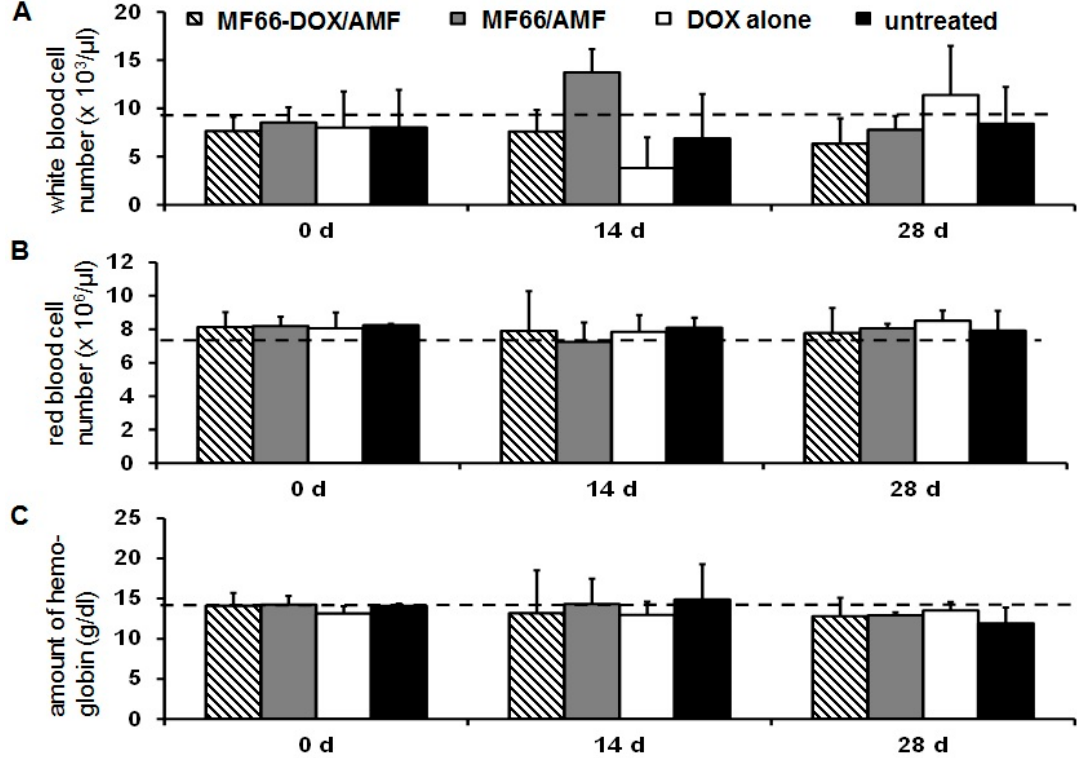
Figure 3. MNPs functionalized with DOX exert a good blood biocompatibility. White blood cells ( A ), red blood cells ( B ) and hemoglobin concentration ( C ). Mean ± standard deviation (n ≥ 4 mice per group). Dashed lines refer to reference values (Harlan Laboratories, Venray, The Netherlands; http://www.harlan.com).